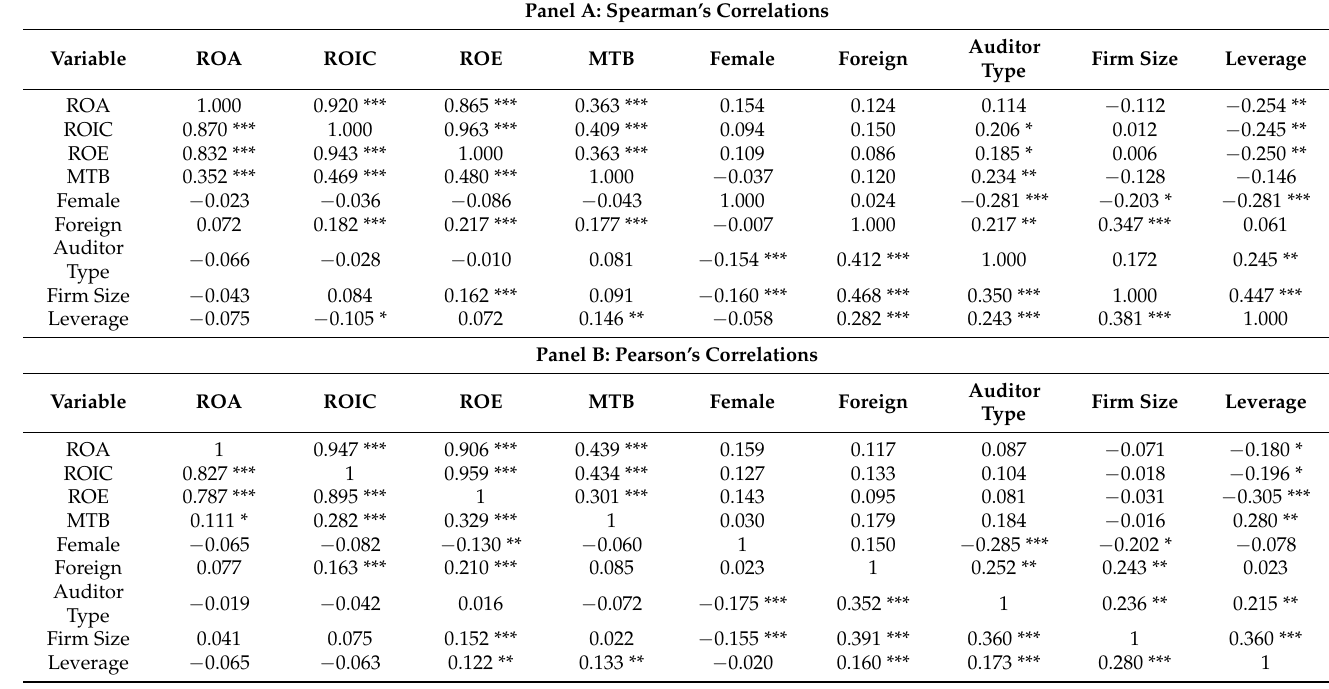
Table 4. Correlation analysis. Panel A: Spearman’s Correlations